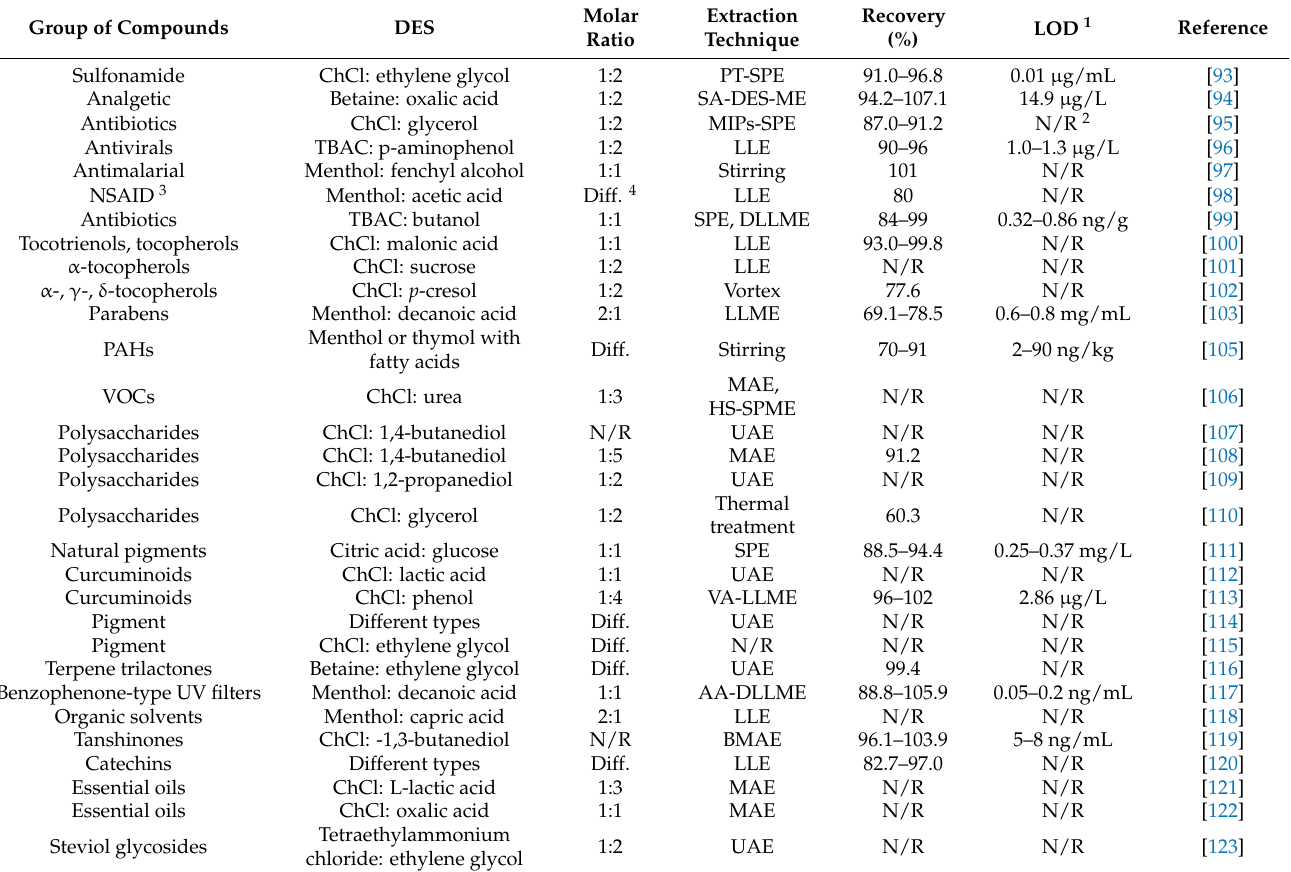
Table 3. Summary and analytical performance of the methods discussed from Sections